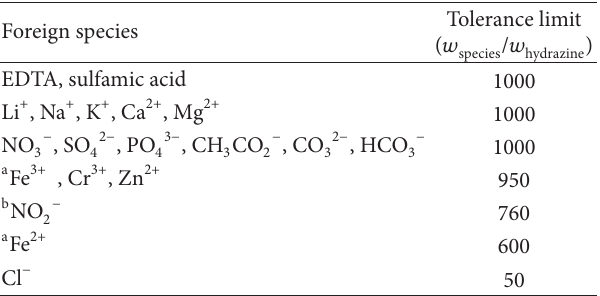
T 1: Tolerance limit for various species for the determination